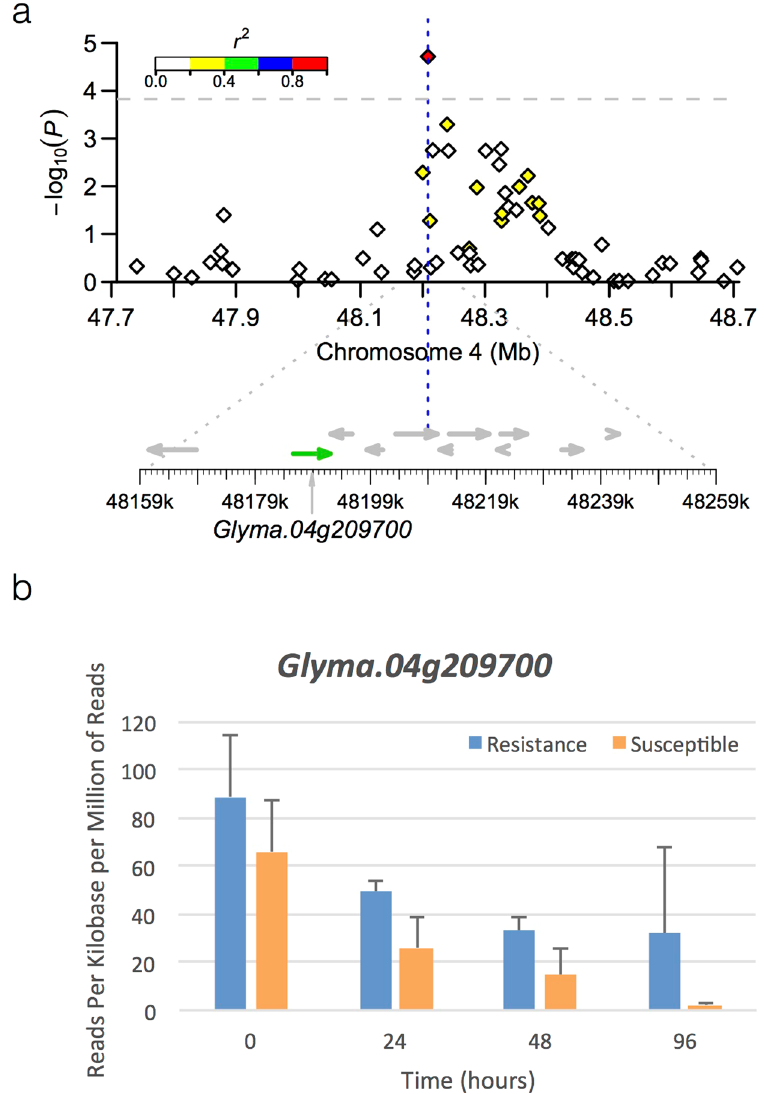
Figure 2. Regional association plot of ss715588567 associated with 14GHSE-DAI03 and expression of the putative candidate gene Glyma . 04g209700 . ( a ) The top panel shows the negative log10-transformed P values from a genome-wide scan by using a mixed linear model (MLM) for plant severity taken 3 DAI within the adjacent region of peak SNP ss715588567 plotted against base pair positions (Mb) on soybean chromosome 4. The significance threshold line is distinguished (gray dotted line), and each SNP depicts the extent of linkage disequilibrium in the region based on pairwise values with respect to the peak SNP. The values are indicated using the color intensity index shown. The bottom panel shows all putative genes in the region. The putative candidate gene indicated in green. ( b ) The expression of Glyma . 04g209700 , the putative candidate gene for ss715588567 , in a modern resistant (blue) and susceptible (orange) cultivar. Error bars shown to indicate significance (p <